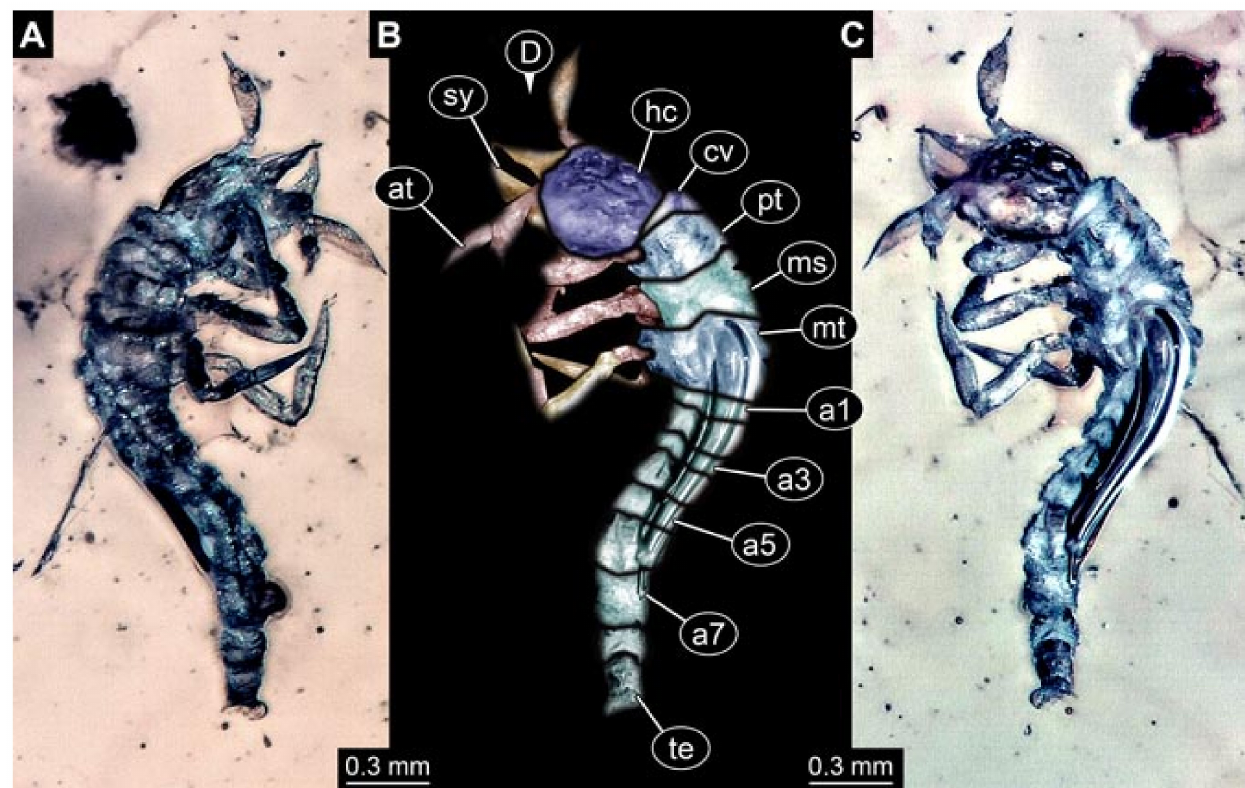
Figure 20. Specimen 5849 (BUB 3711a); Myanmar amber. ( A ) Latero-ventral view. ( B ) Latero-dorsal view, colour-marked. ( C ) Dorsal view. Abbreviations: a1–a7 = abdomen segments 1–7; at = antenna; cv = cervix; hc = head capsule; ms = mesotho- rax; mt = metathorax; pt = prothorax; sy = stylet; te = trunk